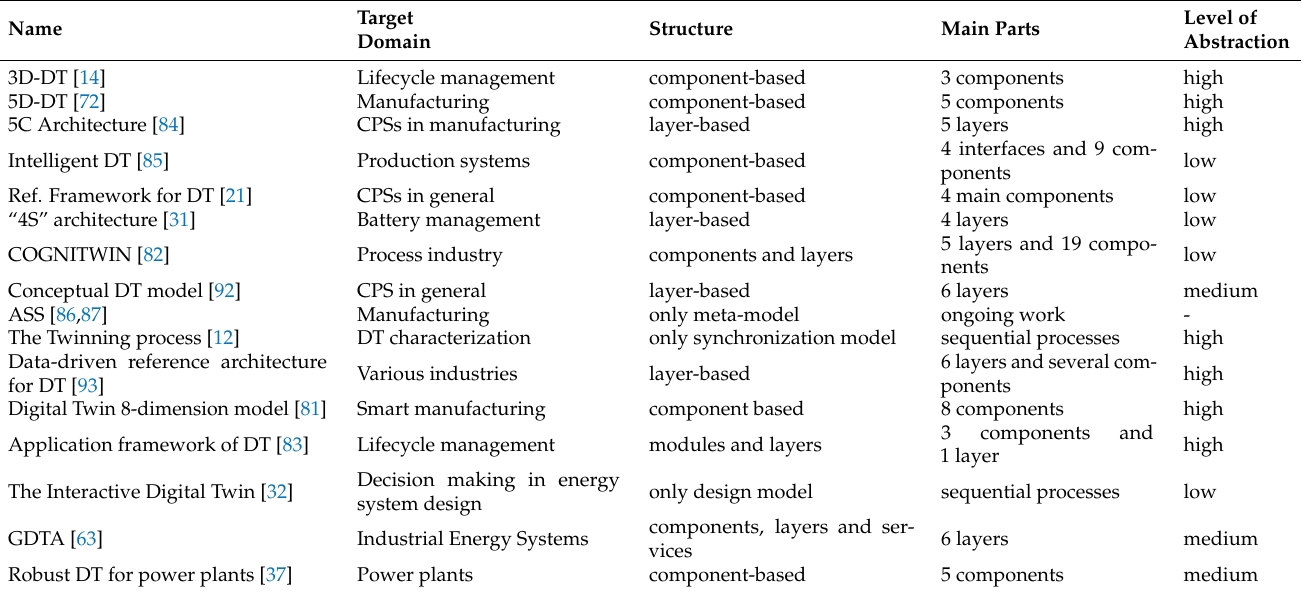
Table 4. Overview of concepts, architectures and frameworks for DTs. Adapted and extended from Steindl et al.